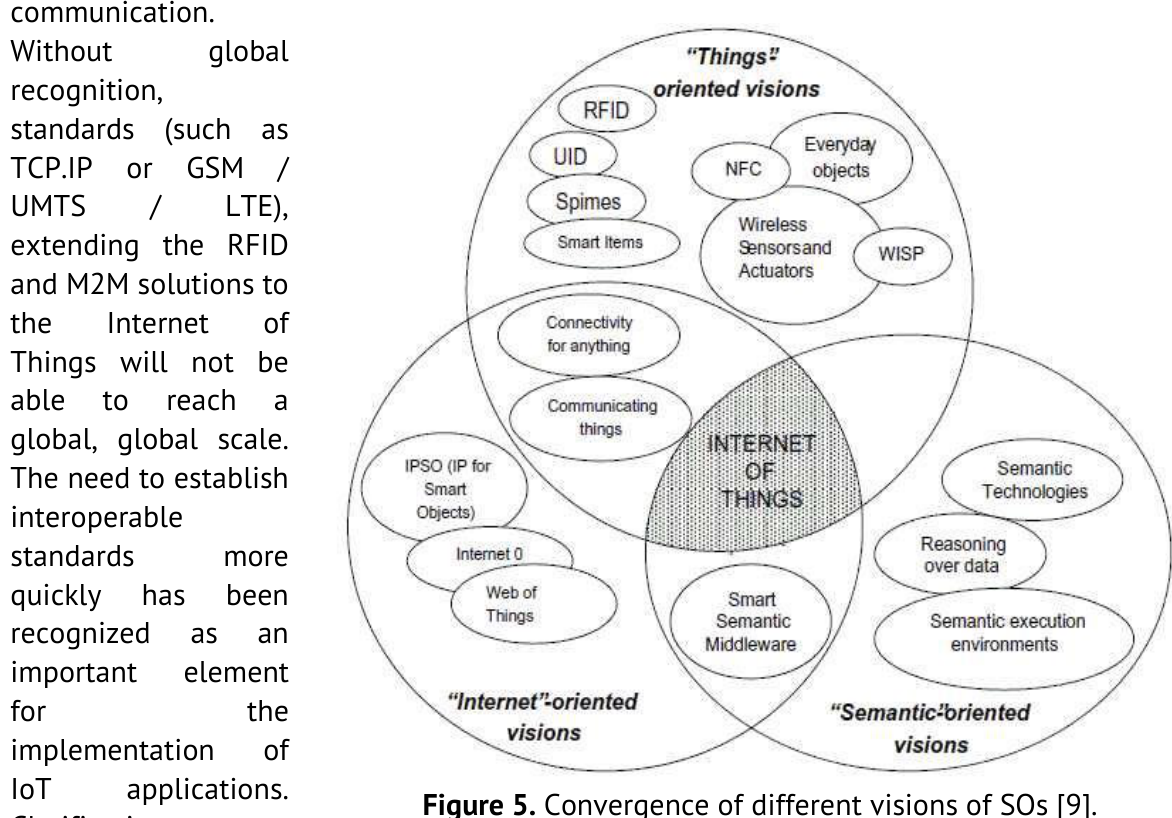
Figure 5. Convergence of different visions of SOs